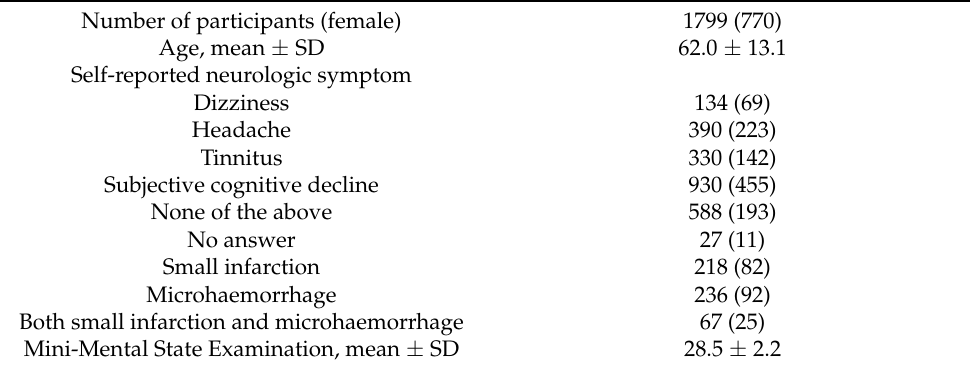
Table 1. Demographic data for all